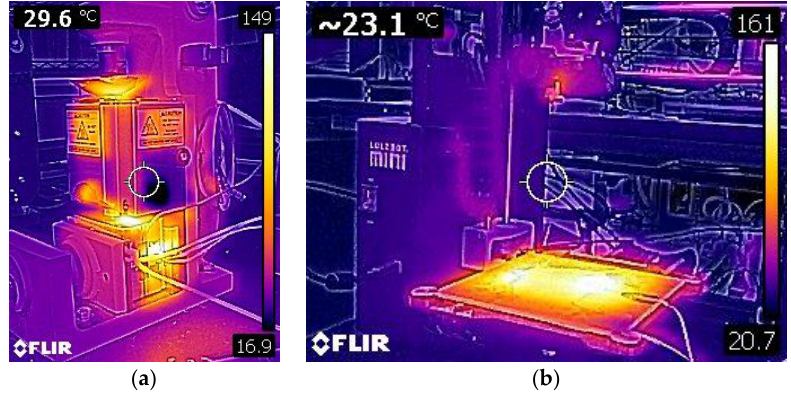
Figure 4. Injection molding setup heating to the set temperature (150 °C) ( a ) and a modified 3D printer (Lulzbot Mini) to print precursor Aquivion filament heating to set temperatures (the extruder is set to 260 °C and the bed is set to 180 °C) ( b ).